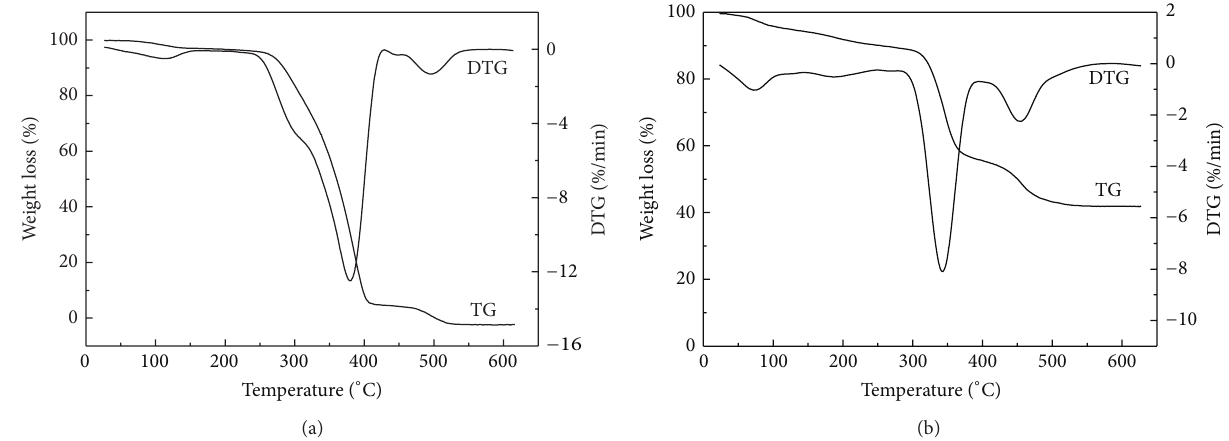
Figure 1: TG-DTG curves of the PS spheres (a) and the TiO 2 /PS composite.